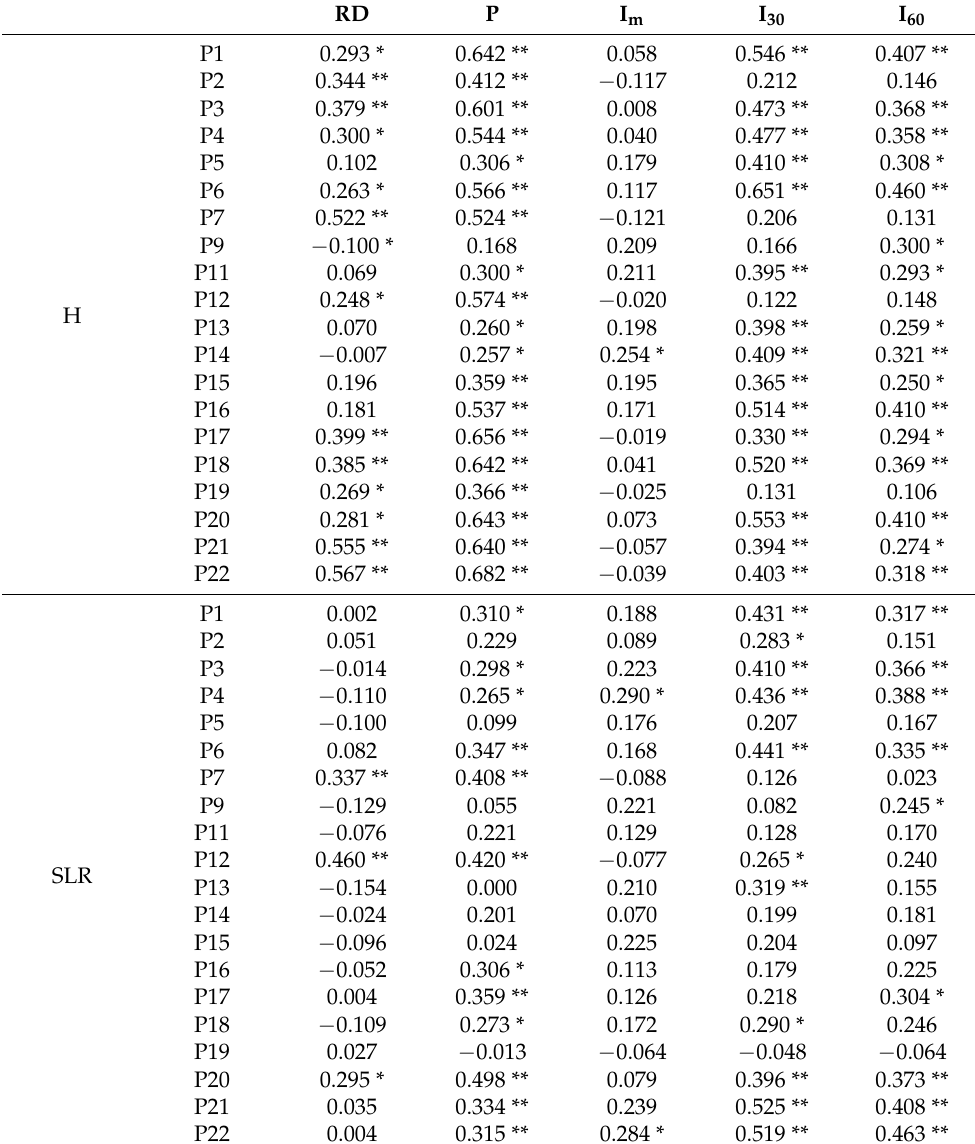
Table 4. Pearson coefficient matrix between the five rainfall eigenvalues, event runoff depth (H), and event soil loss rate SLR for 66 rainfall events in